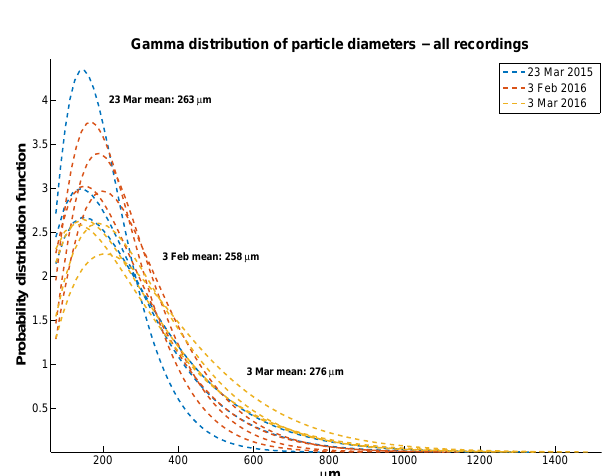
Figure 3. Two-parameter Gamma distributions of particle diame- ters from each recording. Diameter measurements were obtained through black and white video binarization and equivalent diameter calculations of flood-fill identified connected